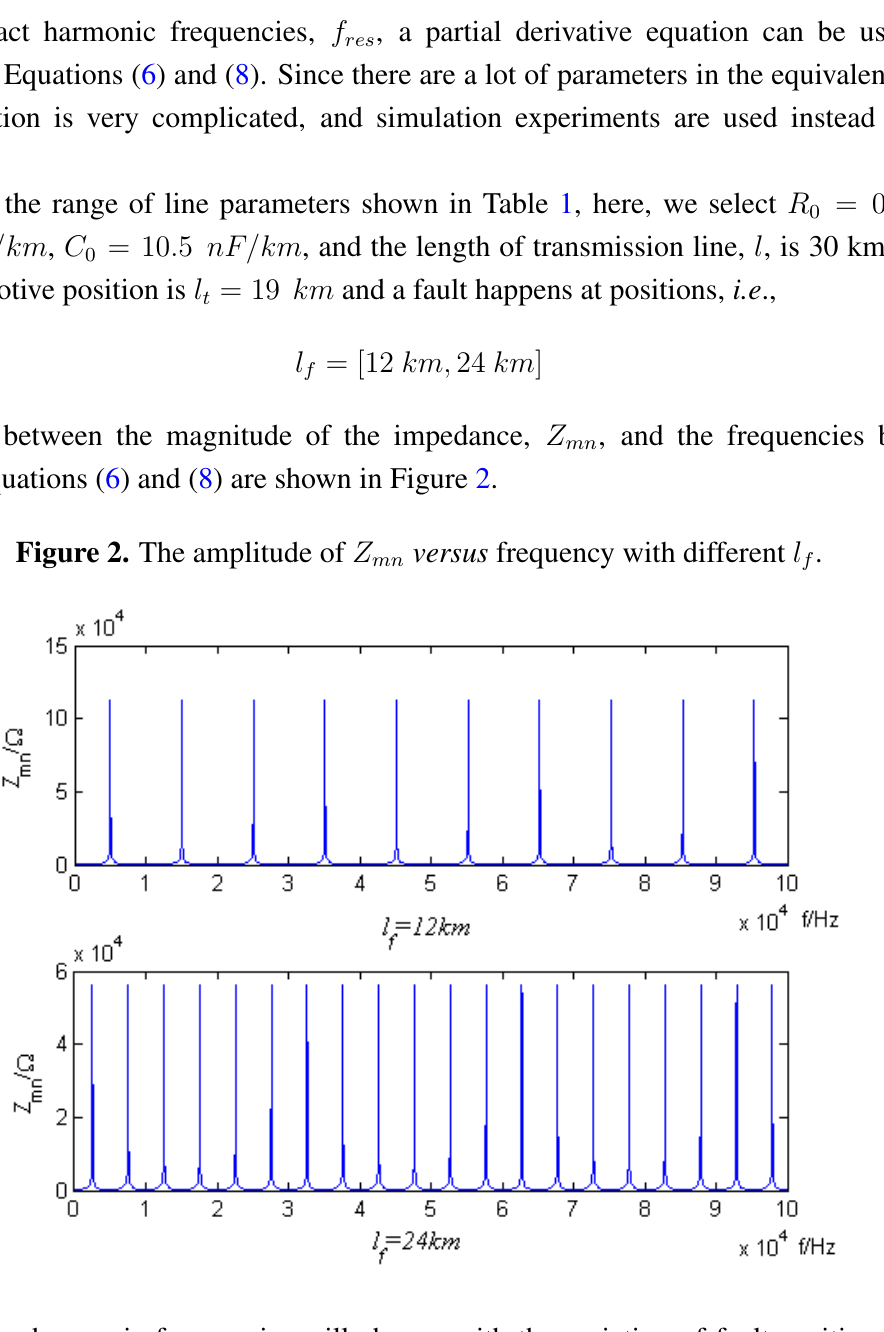
Figure 2. The amplitude of Z